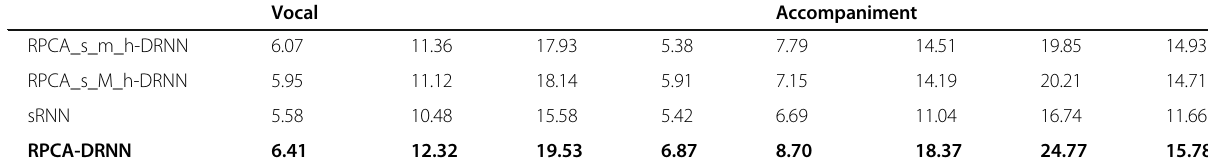
Table 2 Experiment results of the ablation study using (a) MIR-1K, (b) ccMixter, and (c) MUSDB18 (Continued)